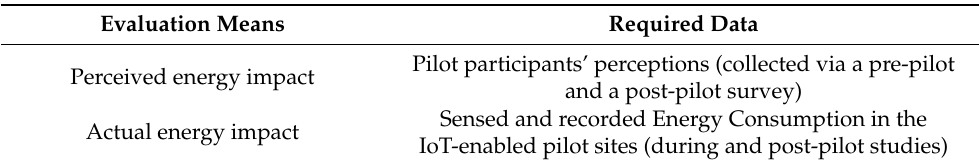
Table 1. Evaluation means and collected